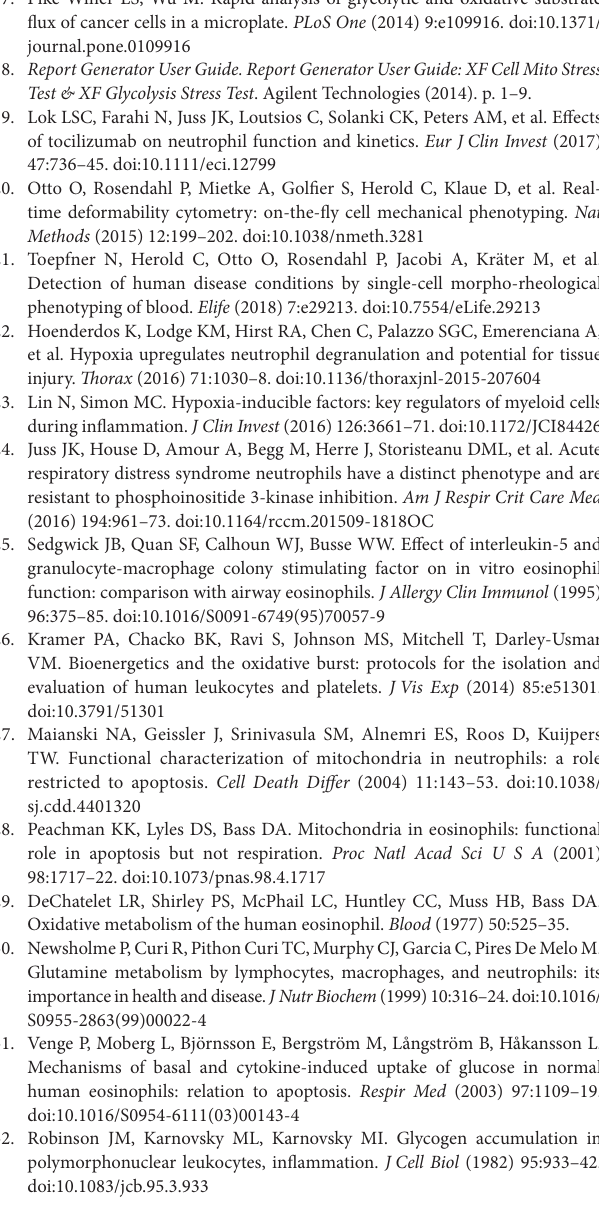
mean ± SD of ≥ 2 independent experiments. Ns indicates a non-significant difference. FigUre s3 | Kinetic extracellular acidification rate (ECAR) and OCR response of eosinophils and neutrophils to glutamine stimulation. (a) Eosinophil ECAR and OCR response to glutamine injection (GLUT, 2 mM) at 36 min, oligomycin (OLIGO, 2.5 µM) at 72 min and 2-DG (100 mM) at 108 min. (b) Neutrophil ECAR and OCR response to glutamine injection (GLUT, 2 mM) at 36 min, OLIGO (2.5 µM) at 72 min, and 2-DG (100 mM) at 108 min. Data represent the mean ± SD of a single experiment, representative of two. Eosinophil and neutrophil ECAR and OCR responses were measured simultaneously on the same assay plate. FigUre s4 | Kinetic extracellular acidification rate (ECAR) and OCR response of eosinophils to IL-5 stimulation. Eosinophil OCR and ECAR response to IL-5 injection (10 ng/ml) at 20 min, glucose injection (GLUC, 10 mM) at 35 min, oligomycin (OLIGO, 2.5 µM) at 60 min, and 2-DG (100 mM) at 75 min. Data represent the mean ± SD of two independent experiments.